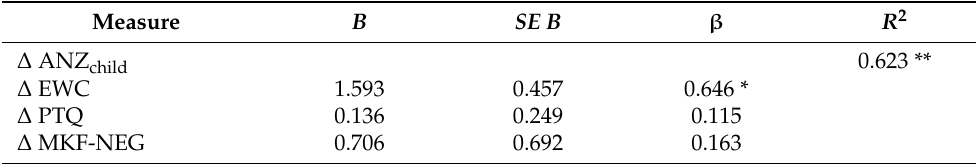
Table 4. Linear Model of predictors for anxiety symptom